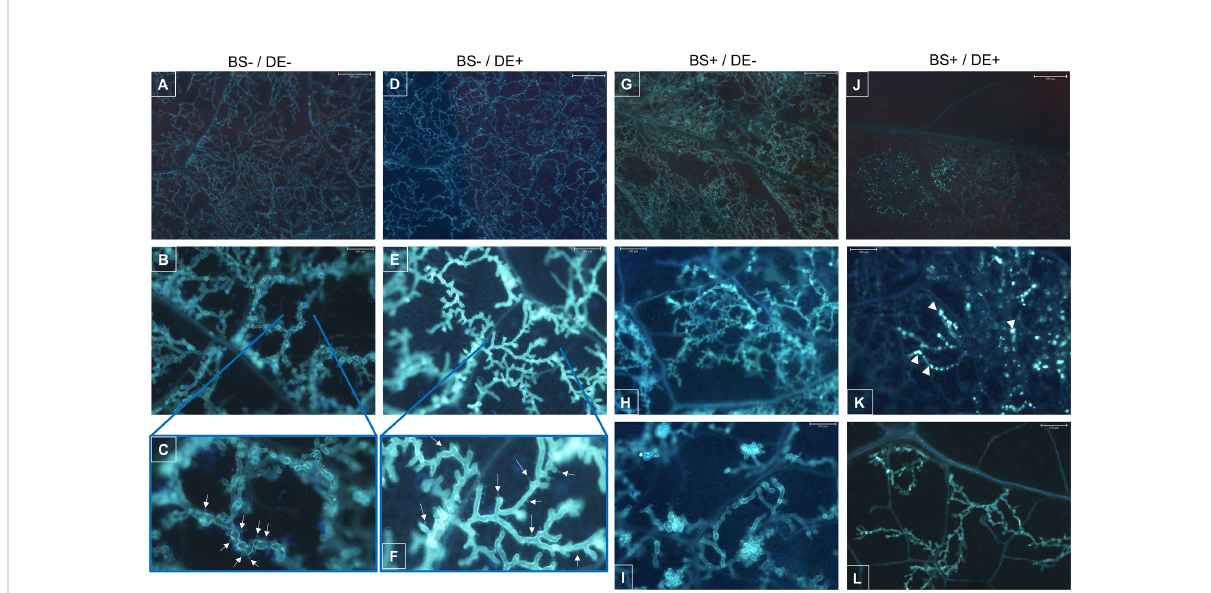
FIGURE 11 Cytological observations of the mycelial colonization of grapevine leaves by Plasmopara viticola . Micro-cuttings were transplanted in a solid medium supplemented with BS 0.1% (v/v, “ BS+ ” ) or water ( “ BS- ” , as control). At 4 wpt, they were divided into two sets: one treated by immersion in a defense elicitor solution (DE+) and the other one in water as control (DE-). Two days later, leaves were detached and inoculated with a P. viticola sporangia suspension. The mycelial development into leaves was observed at 7 dpi, by microscopy, under UV, after aniline blue staining. (A – C) samples collected from BS-/DE- plantlets; showing the importance of mycelial colonization (A) , the typical structure of hyphae and their branching (B) as well as the presence of haustoria ( C , arrows). (D – F) samples collected from BS-/DE+ plantlets; showing the importance of mycelial colonization (D) , the structure of hyphae and their branching (E) as well as the presence of haustoria ( F , arrows). (G – I) : samples collected from BS+/DE- plantlets; showing the importance of mycelial colonization (G) , the structure of hyphae and their branching (H, I) . (J – L) : samples collected from BS+/DE+ plantlets; showing a reduced internal colonization (J) , with, in some areas, altered hyphae presenting inside a material with af fi nity for aniline blue, therefore composed of b -1,3 glucan ( J; K , arrowheads). In other areas, hyphae appear less affected but are sparse and haustoria are not apparent (L) . The scale bar corresponds to 500 m m (A, D, G, J) , or 100 m m (B, E, H, I, K, L)